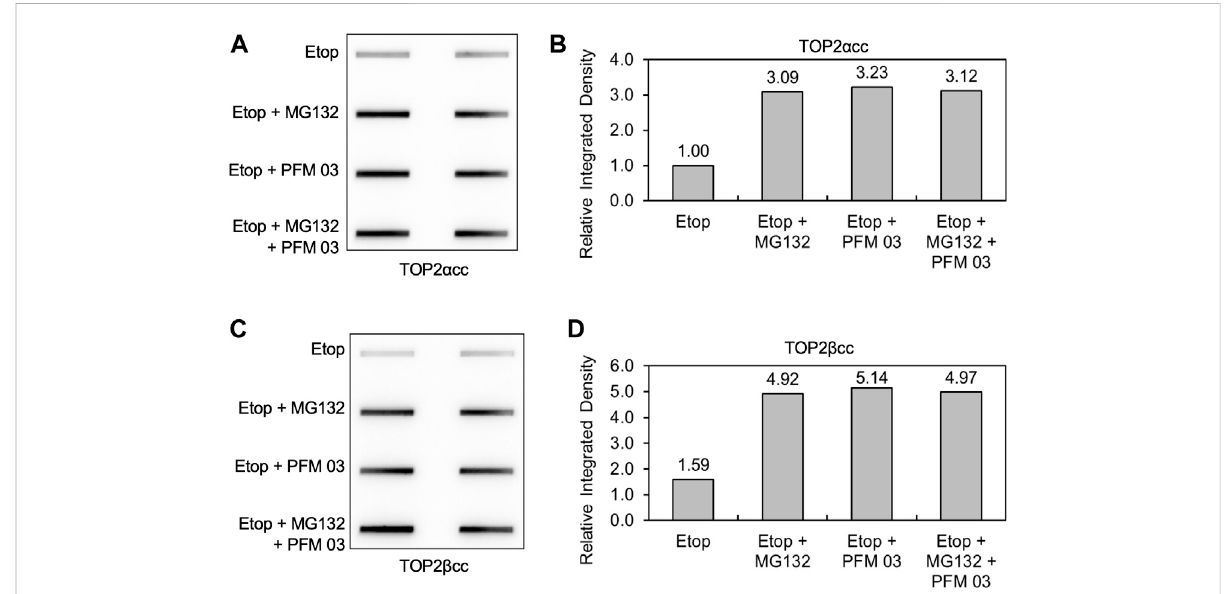
FIGURE 6 MRE11 inhibitors do not enhance levels of covalent complexes upon concurrent treatment with proteasome inhibitors. RH30 cells were pre- treatedwith25 μ MPFM03,10 μ MMG132,or25 μ MPFM03+10 μ MMG132for4 h.Etoposide(10 μ M)wasadded,andincubationwascontinuedfor 2 h before ICE assays. (A) Representative ICE assay measuring the levels of TOP2 α cc. (B) Densitometric analysis of all assays comparing relative integrated densities of TOP2 α cc signals. Integrated density of TOP2 α cc signal of each group was normalized to that of cells treated